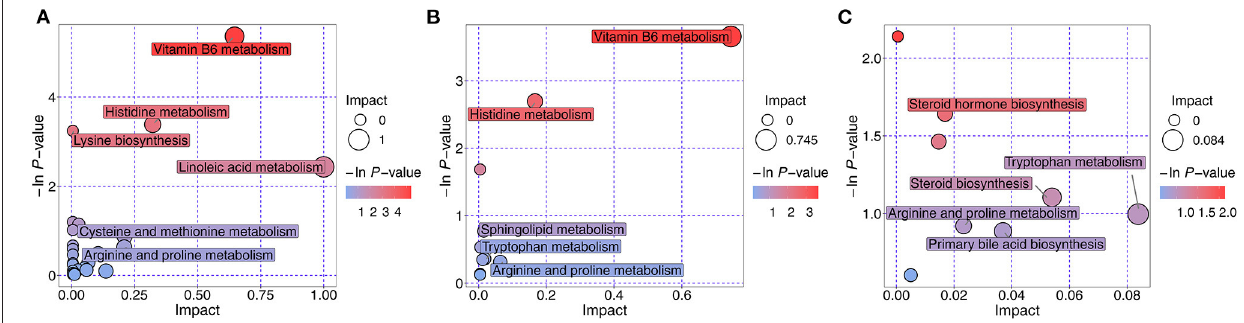
FIGURE 10 | Metabolic pathway analysis of differentially expressed metabolites in the feces of mice. (A) : NT-free group compared with NT intervention group; (B) : basal diet group compared with NT intervention group; (C) : basal diet group compared with model control